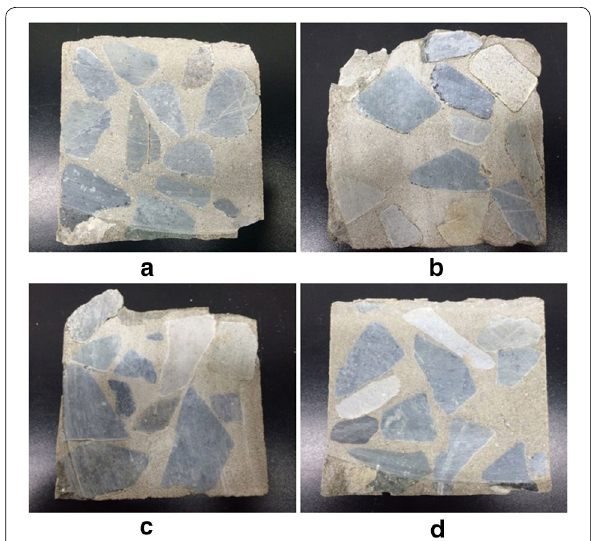
Fig. 21 Specimen sections with H-level aggregates after freeze–thaw testing: a C-H-0, b C-H-2, c C-H-6, and d C-H-10.